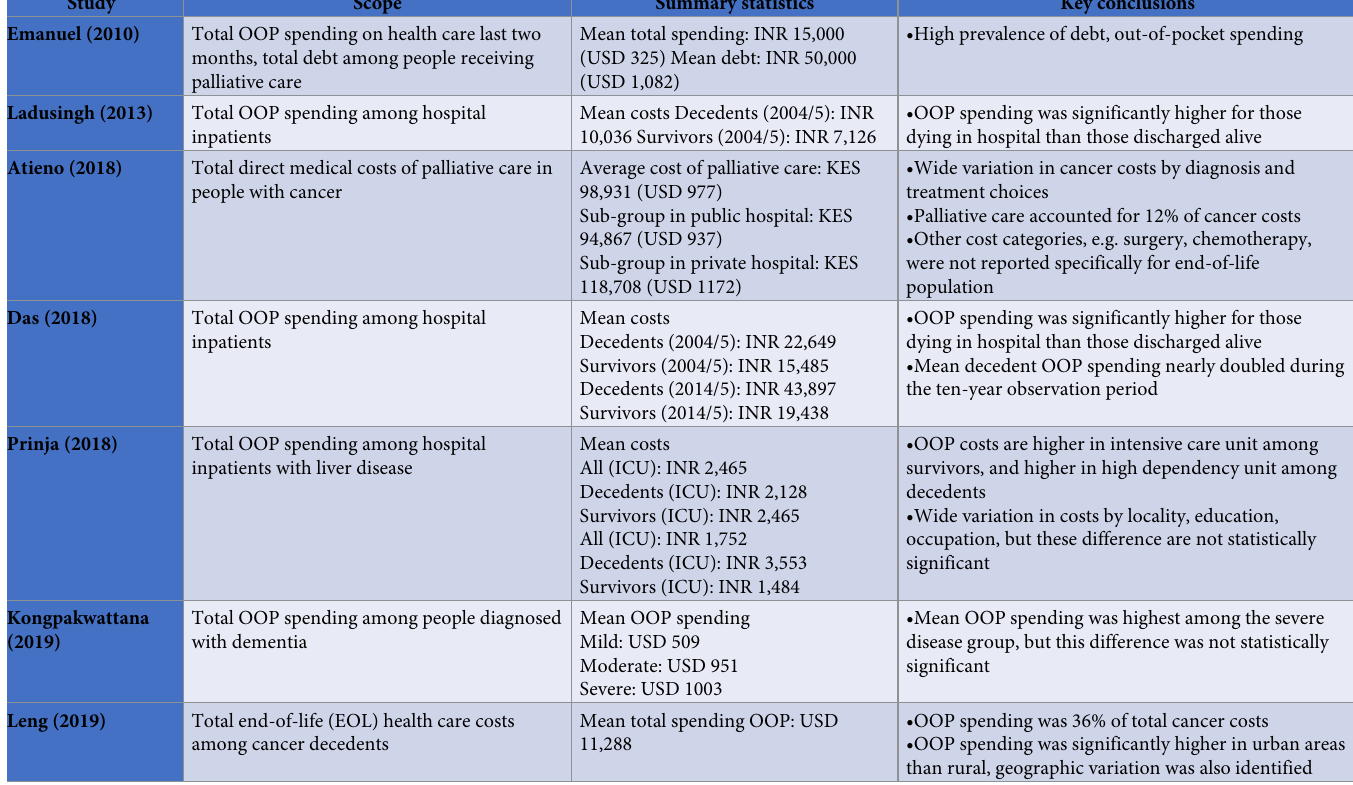
Table 4. Results of studies quantifying out-of-pocket spending,